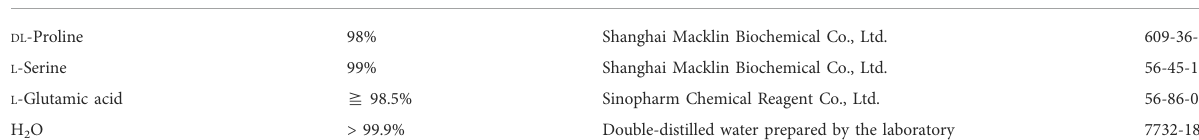
TABLE 1 Chemicals used in the study